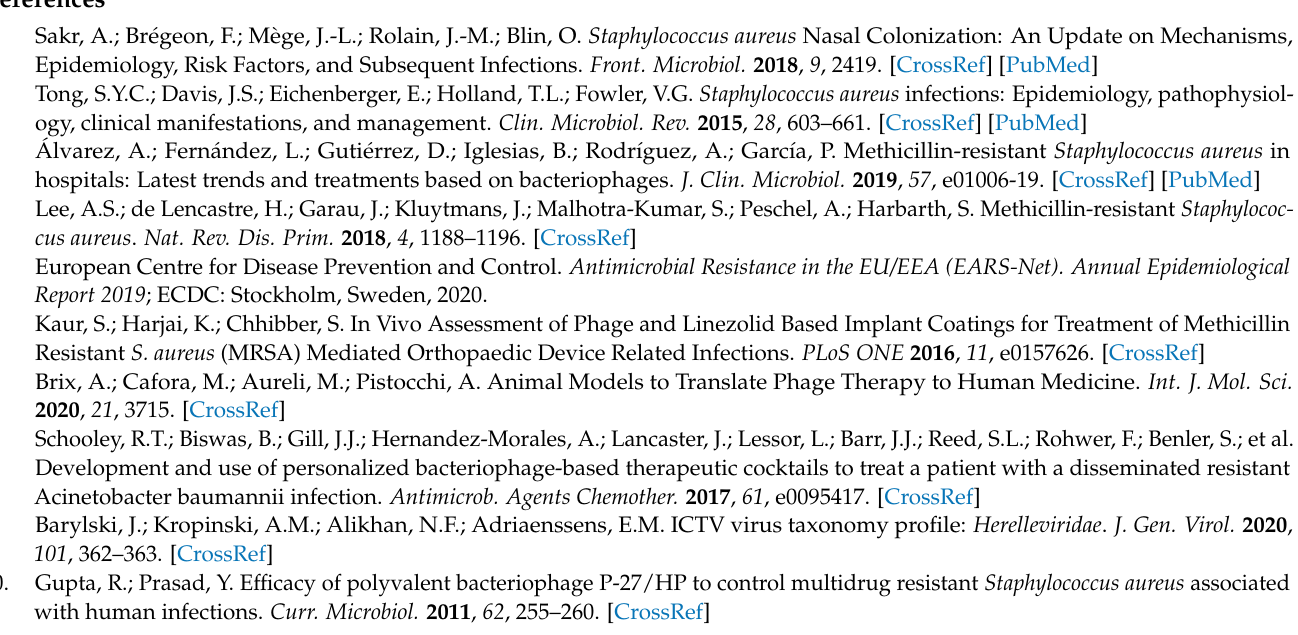
all replicates. Figure S3: Venn diagram showing the overlap between lists of DEGs at different time points post-infection. Table S1: S. aureus strain SA515 annotation. Table S2: Gene expression profiles of S. aureus SA515 infection with the vB_SauM-515A1 bacteriophage. Table S3: Virulence factor genes of